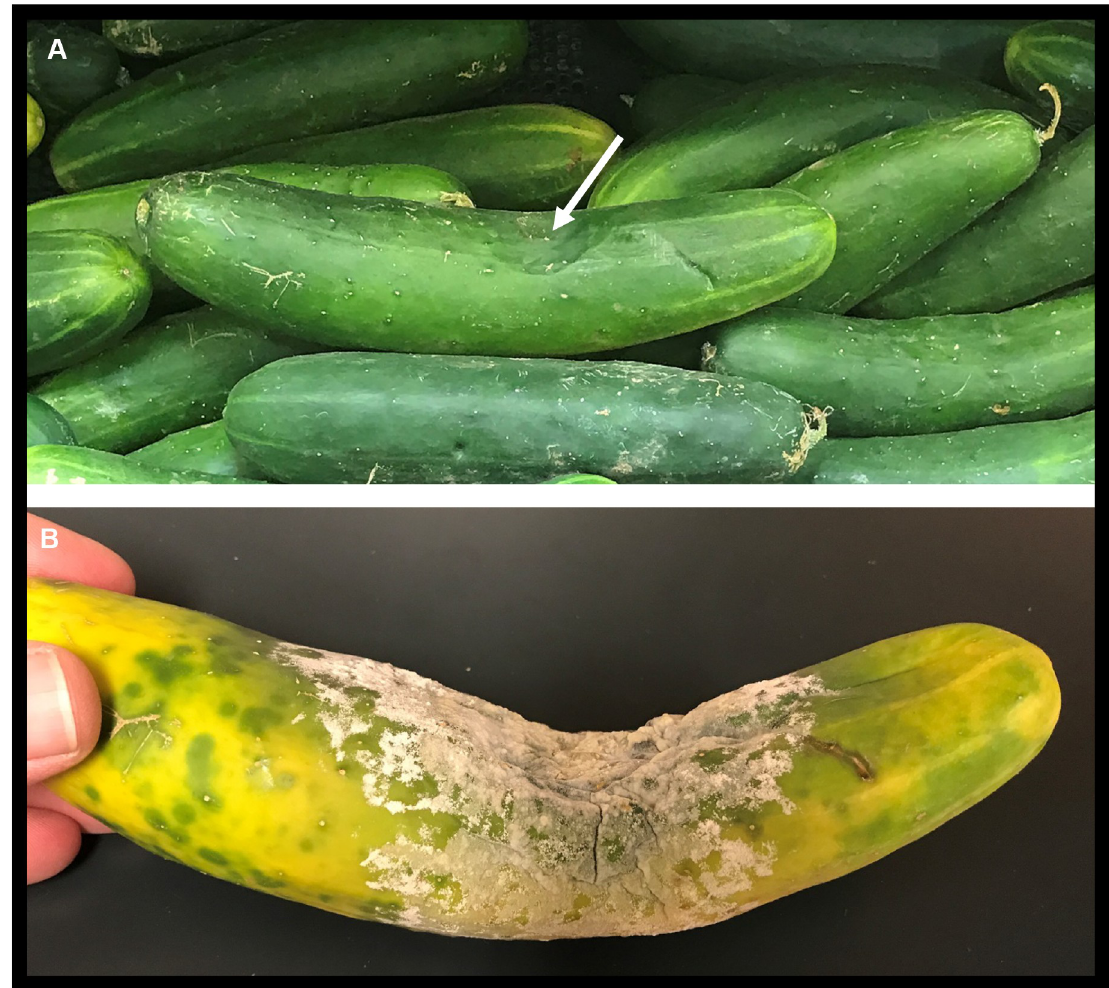
Fig 2. Cucumber fruit recovered August 3, 2017 from major supermarket chain in Knoxville, Tennessee (origin unknown). A, white arrow designates typical sunken, firm lesion produced by infection with P . capsici . B, the same fruit producing millions of asexual sporangia-spores after three days incubation under ambient (outdoor) conditions (K. Lamour, Knoxville, TN, Aug